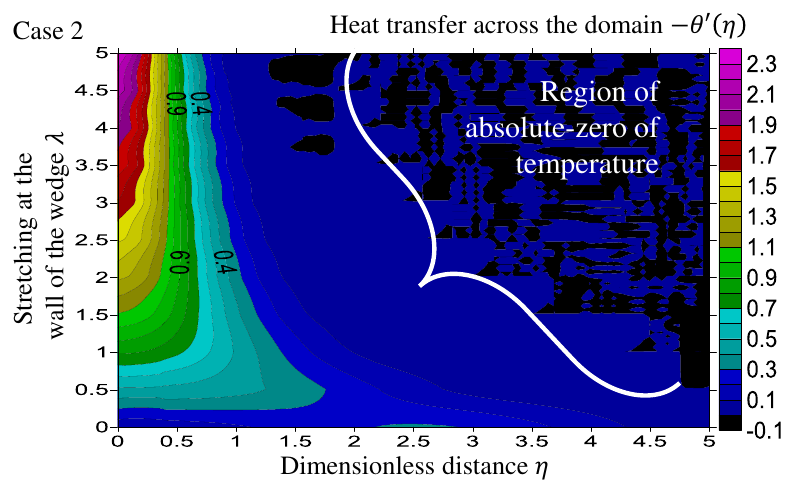
Figure 7. Variation of the heat transfer − θ (cid:48) ( η ) with the wall stretching velocity λ —case 1.